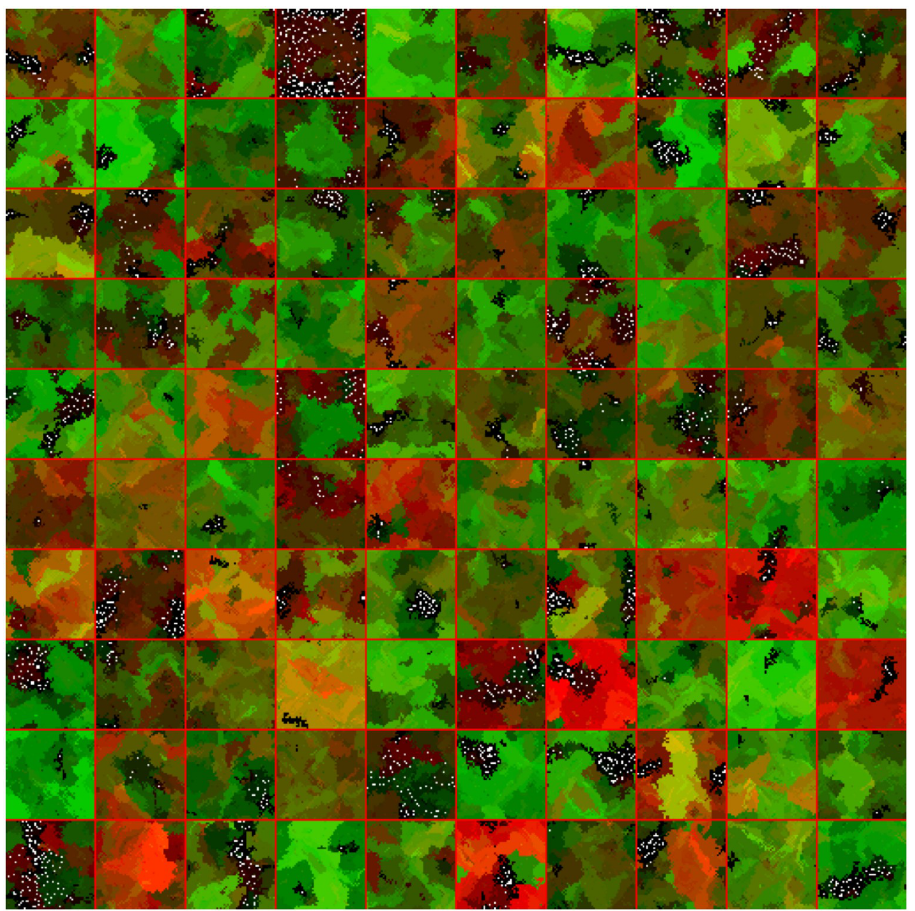
Fig 6. Example of a 10x10 Multi-Well experiment where evolutionary competition of two phenotypes (red,green) shows divergent results with different random seeds. Models are separated with red lines. With a cell radius of 10 μ m, each well has a domain size of 2 × 2